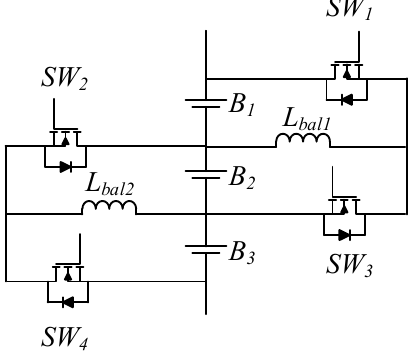
Figure 2. Inductive charge shuttling circuit.